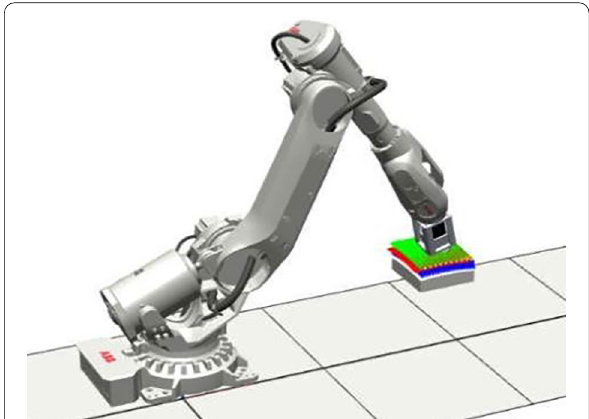
Figure 6 Off-line simulation of bonnet polishing in Robotstudio